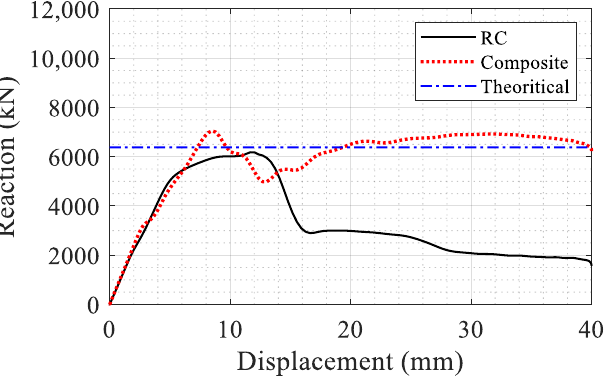
Figure 18. Comparison of the axial capacity of the RC and composite sections.